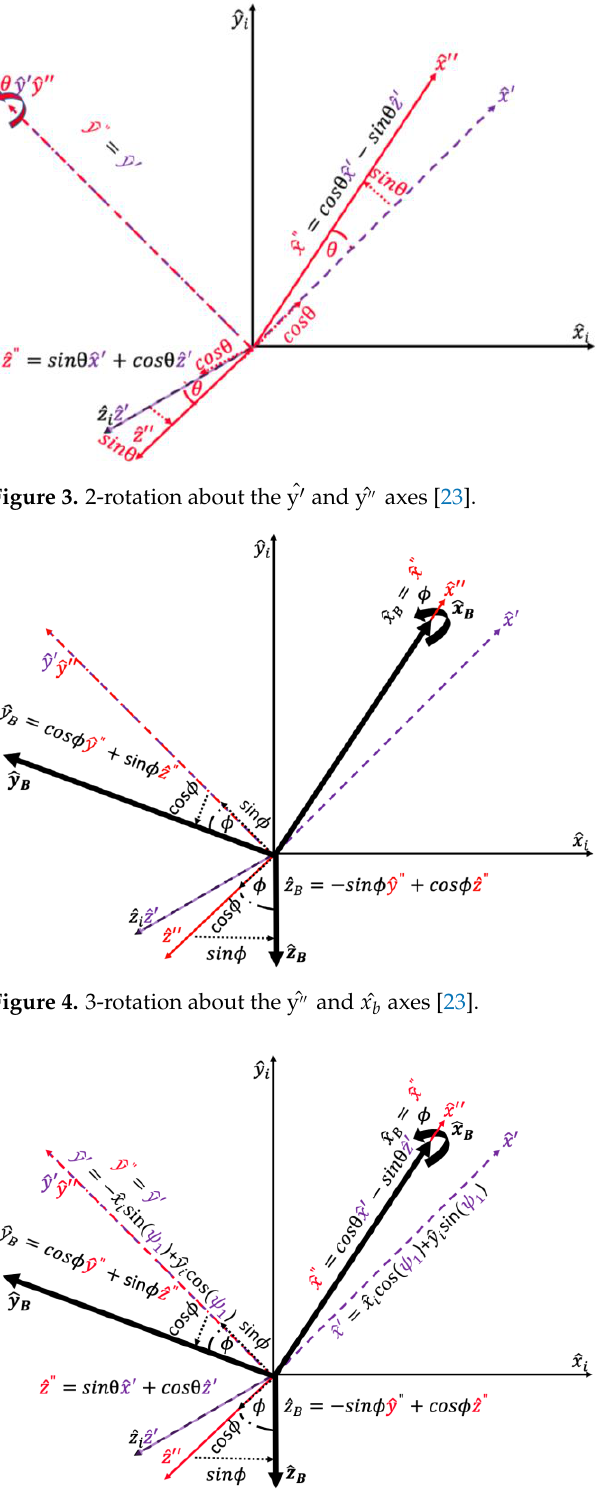
Figure 5. Compiling the 3-, 2-, 1-rotations in one view with all equations [23].